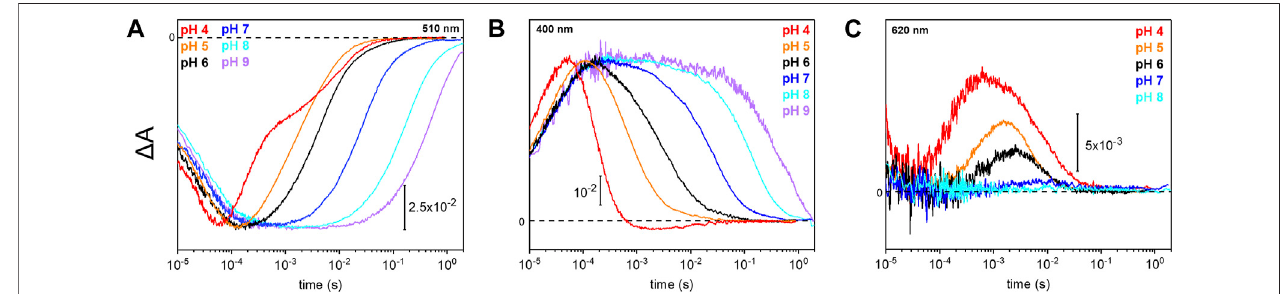
FIGURE 4 | Photoreaction kinetics of Um Rh1 at different pH. Temporal evolution of the fl ash-induced absorption changes of the DDM-solubilized Um Rh1 in the presence of 50 mM buffer mix (100 mM NaCl, 10 mM HEPES, MOPS, MES, citrate and glycine, 0.03% DDM), recorded at different pHs. Photoreaction kinetics of the ground-state bleaching at 510 nm in panel (A) , M state monitored at 400 nm in panel (B) and O state, monitored at 620 nm in panel (C) .